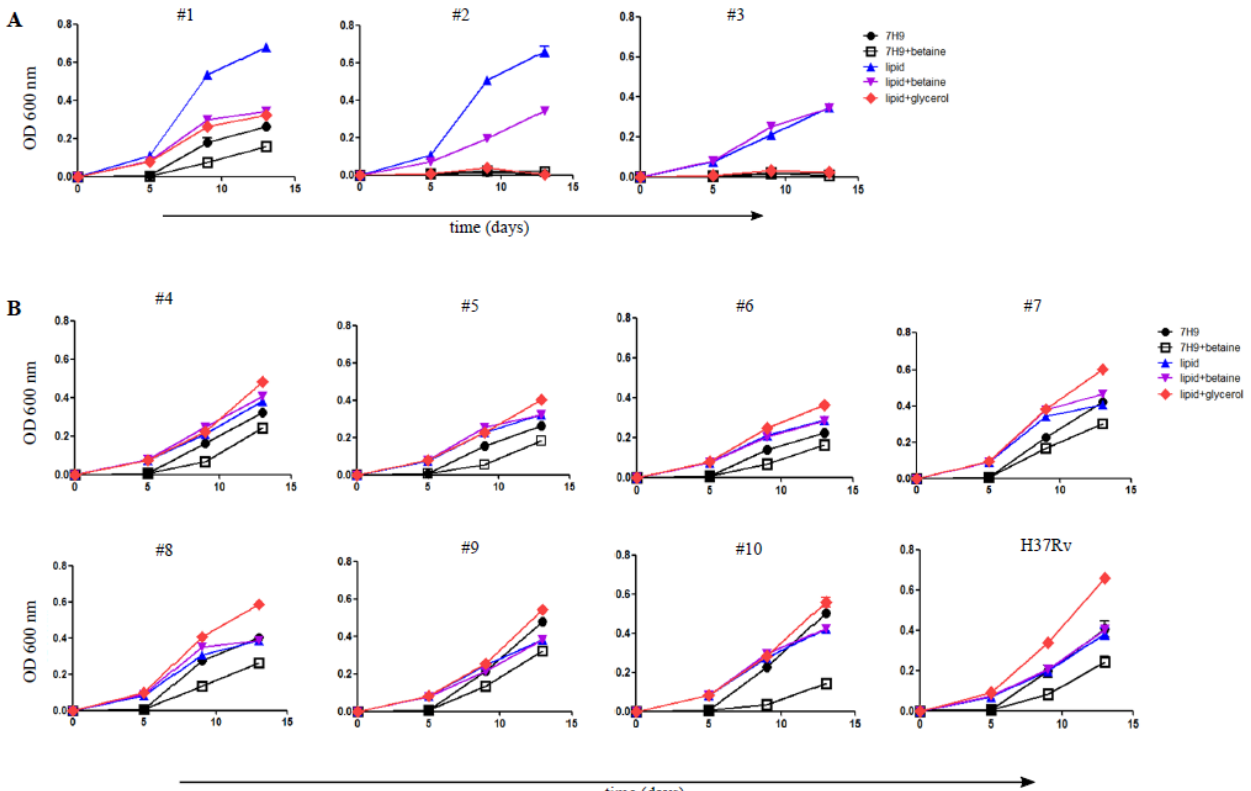
Figure 2. Carbon source culture assay. Growth kinetics of ten lipid-grown strains after transfer to lipid medium in the absence (blue line) or presence of betaine (purple line); glycerol-containing 7H9 in the absence (black line with closed circles) or presence of betaine (black line with open squares); lipid medium supplemented with glycerol (red lines). ( A ) Top panel shows glycerol-sensitive strains. ( B ) Bottom panel shows lipid-resuscitated strains and control H37Rv. Panels ( A , B ) were performed in parallel, so the H37Rv control can be compared in both panels. Points indicate the mean of triplicate cultures from a single experiment. Error bars representing standard deviation are plotted for each measurement; when not visible the error bars are smaller than the data point.